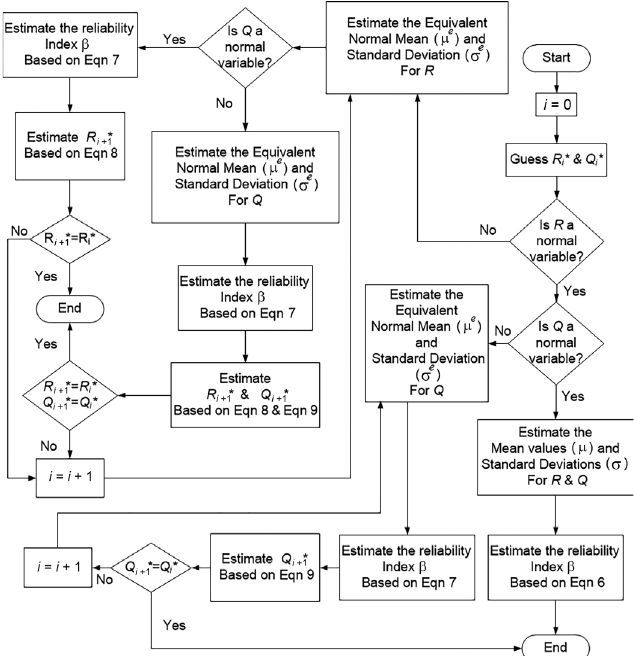
Figure 2. The iterative technique to calculate reliability index b based on normal approximation of non-normal